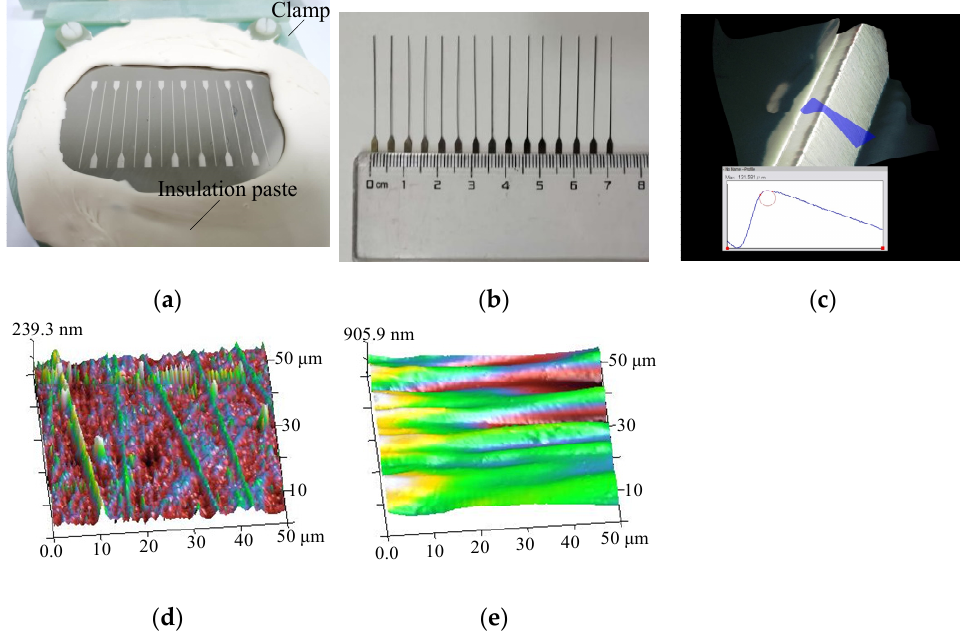
Figure 10. ECD results of pure-nickel rectangular mandrel: ( a ) overall morphology of workpiece after ECD; ( b ) pure-nickel rectangular mandrel; ( c ) edge morphology; ( d ) AFM morphology of bottom surface; ( e ) AFM morphology of side